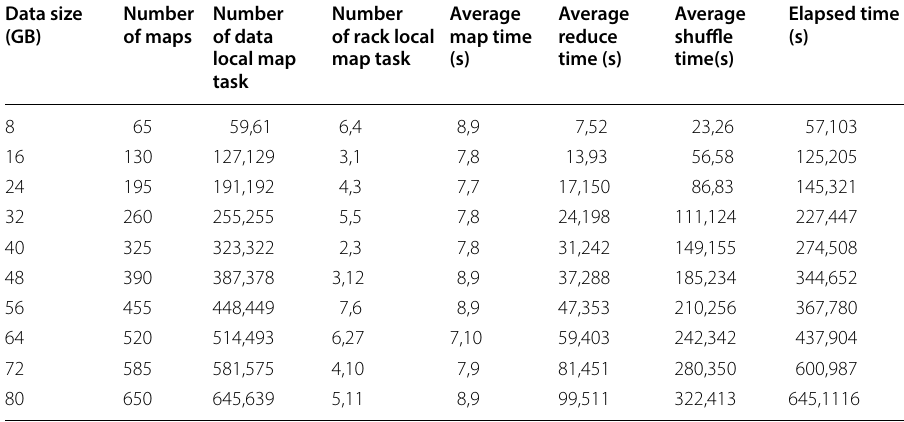
Table 1 Job profile information for experiment of Terasort and Wordcount benchmarks Data size